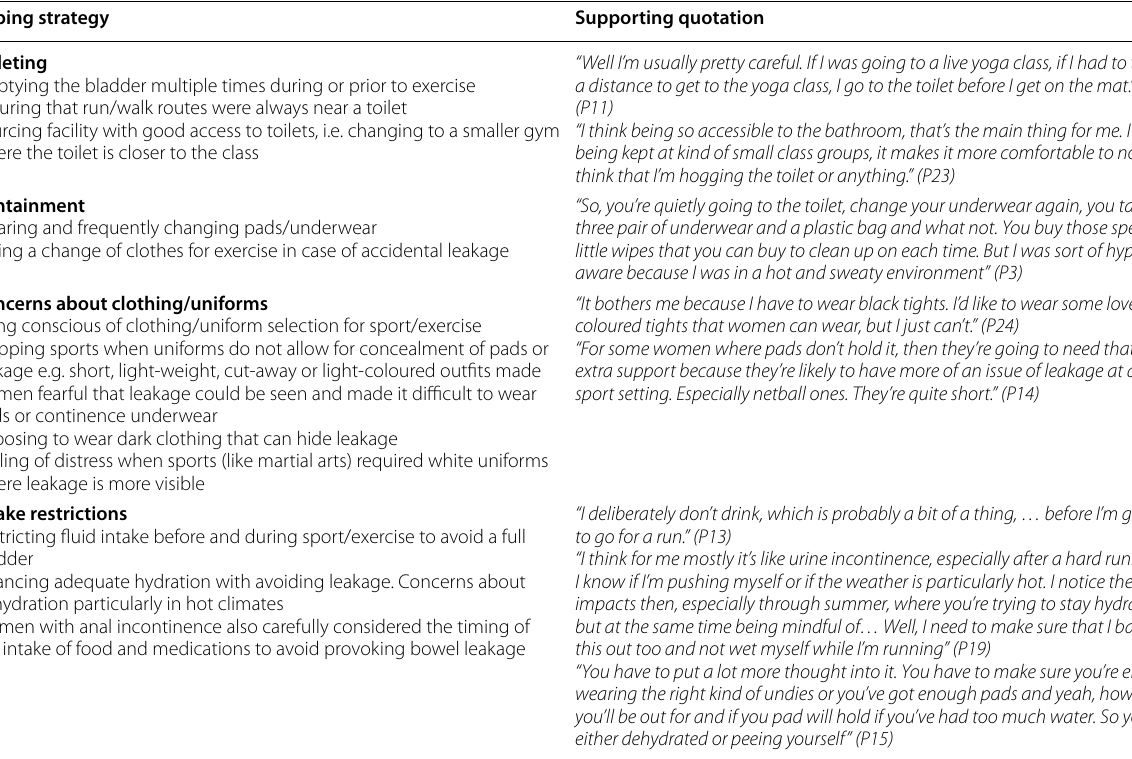
Table 2 Coping strategies for exercising with pelvic floor symptoms Coping